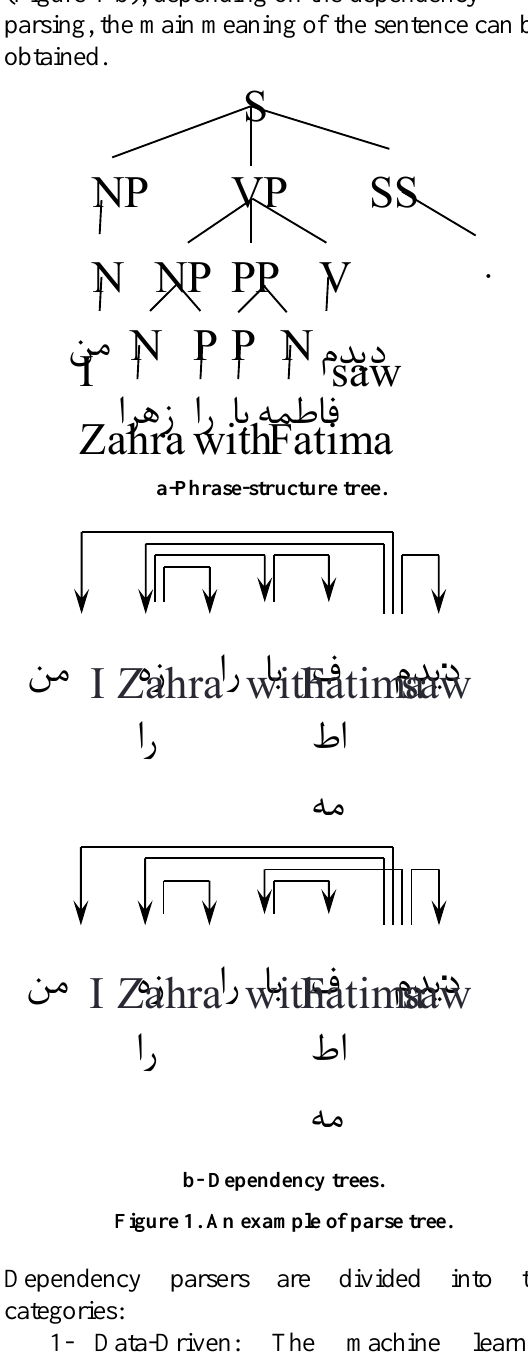
Figure 1. An example of parse